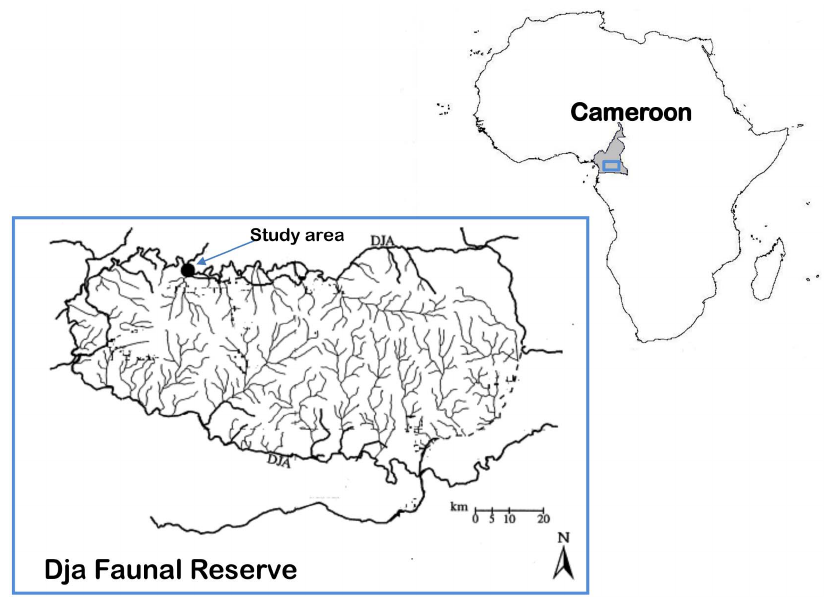
Figure 1. Map of study location at the Dja Faunal Reserve in Cameroon.